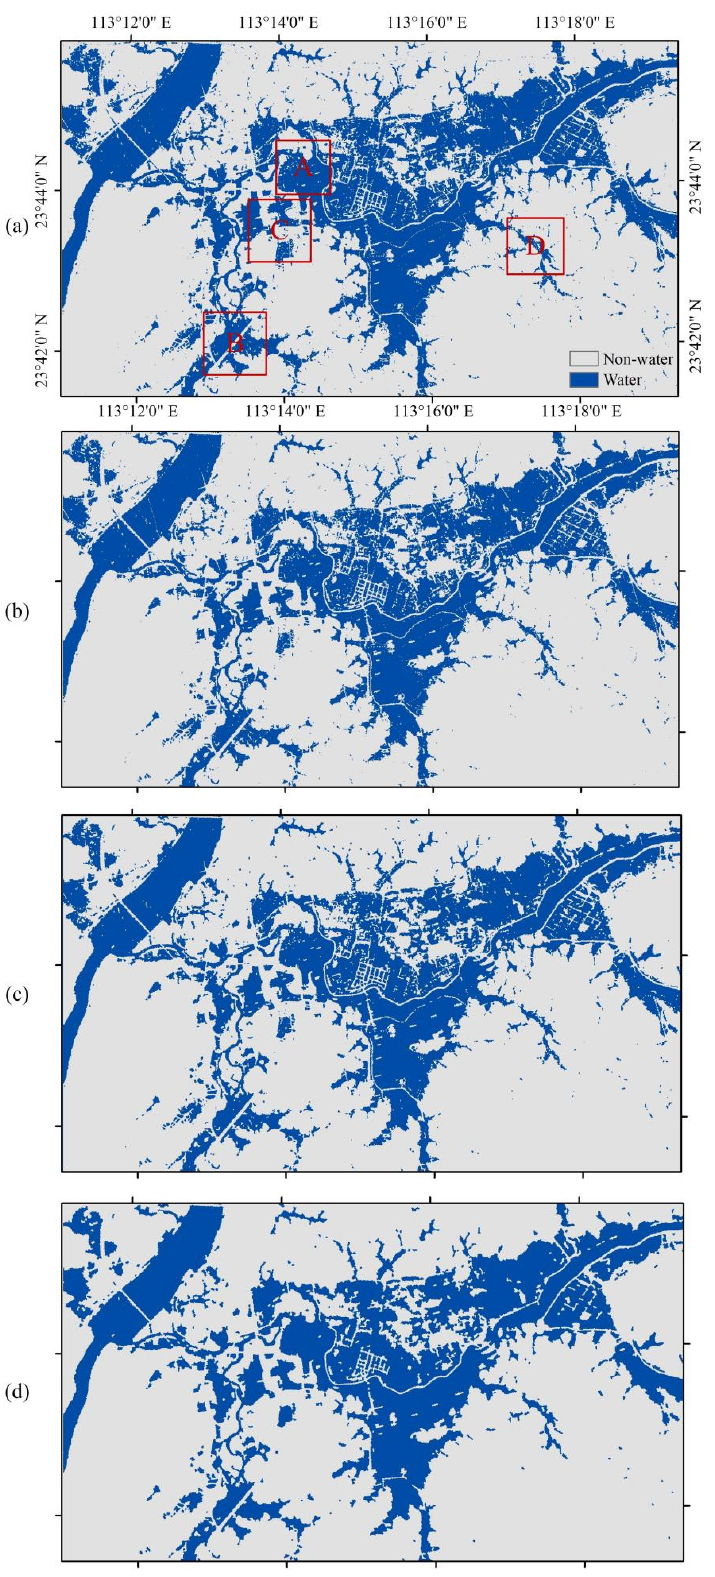
Figure 8. Water delineated by using ( a ) Otsu’s method, ( b ) KI’s method, ( c ) the KI-MRF algorithm, and ( d ) the KI-MRF-SA algorithm in Pajiang. The red boxes mark some remarkably changed spots (A, B, C and D) and method enhancements.